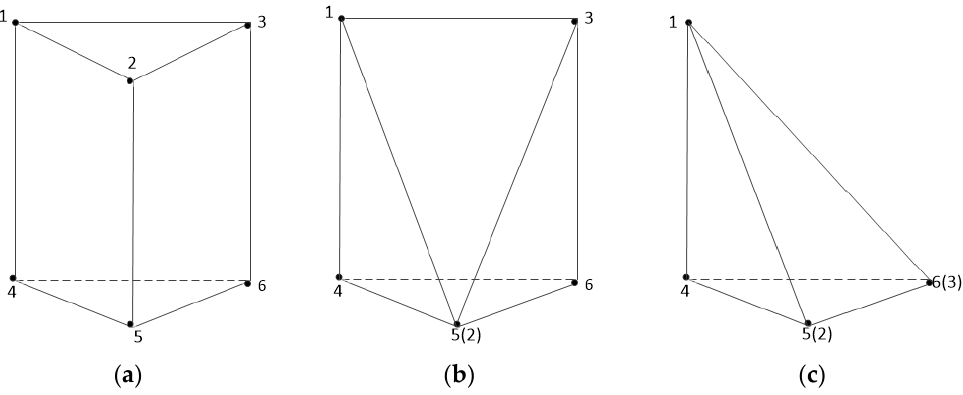
Figure 2. Generalized triangular prism shapes. ( a ) Conventional triangular prism; ( b , c ) degenerated triangular prism.